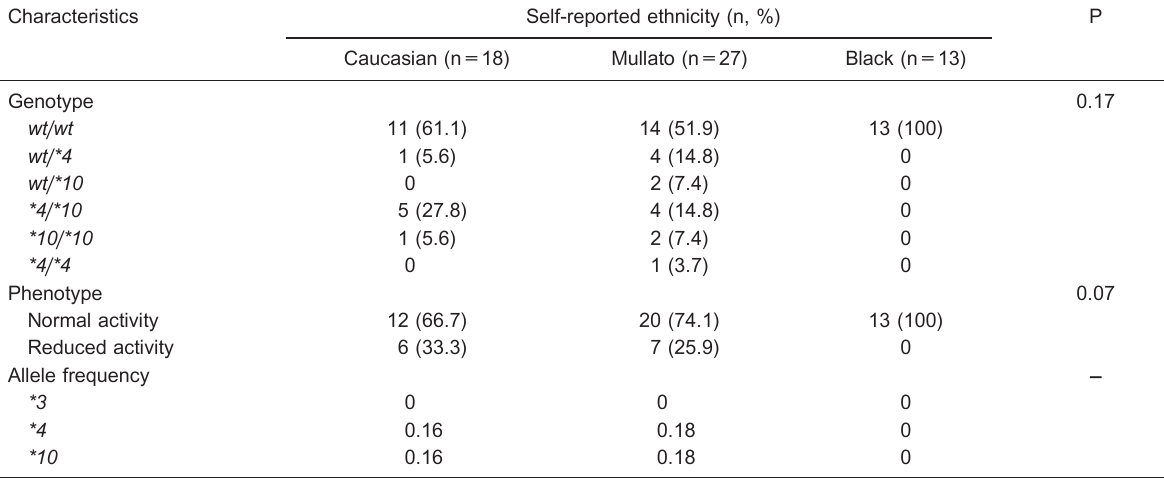
Table 5. Association between the CYP2D6 genotype and phenotype according to patient self-reported ethnicity.